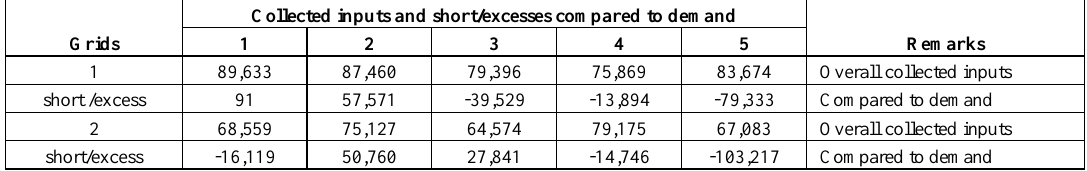
Table 5. Overall status for the collected inputs compared to units needed to fulfill demand for typical grids Collected inputs and short/excesses compared to demand Grids